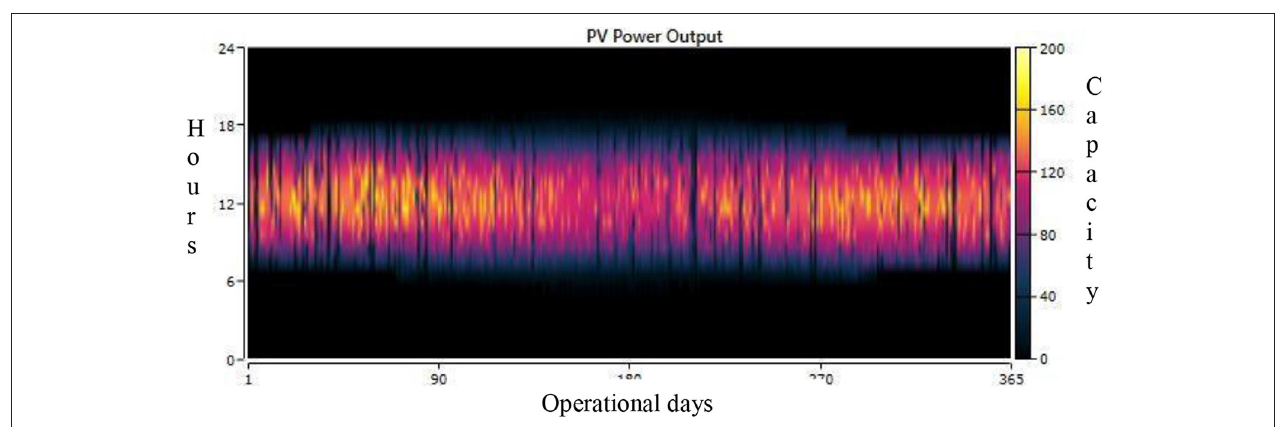
FIGURE 11 | PV power output of the proposed